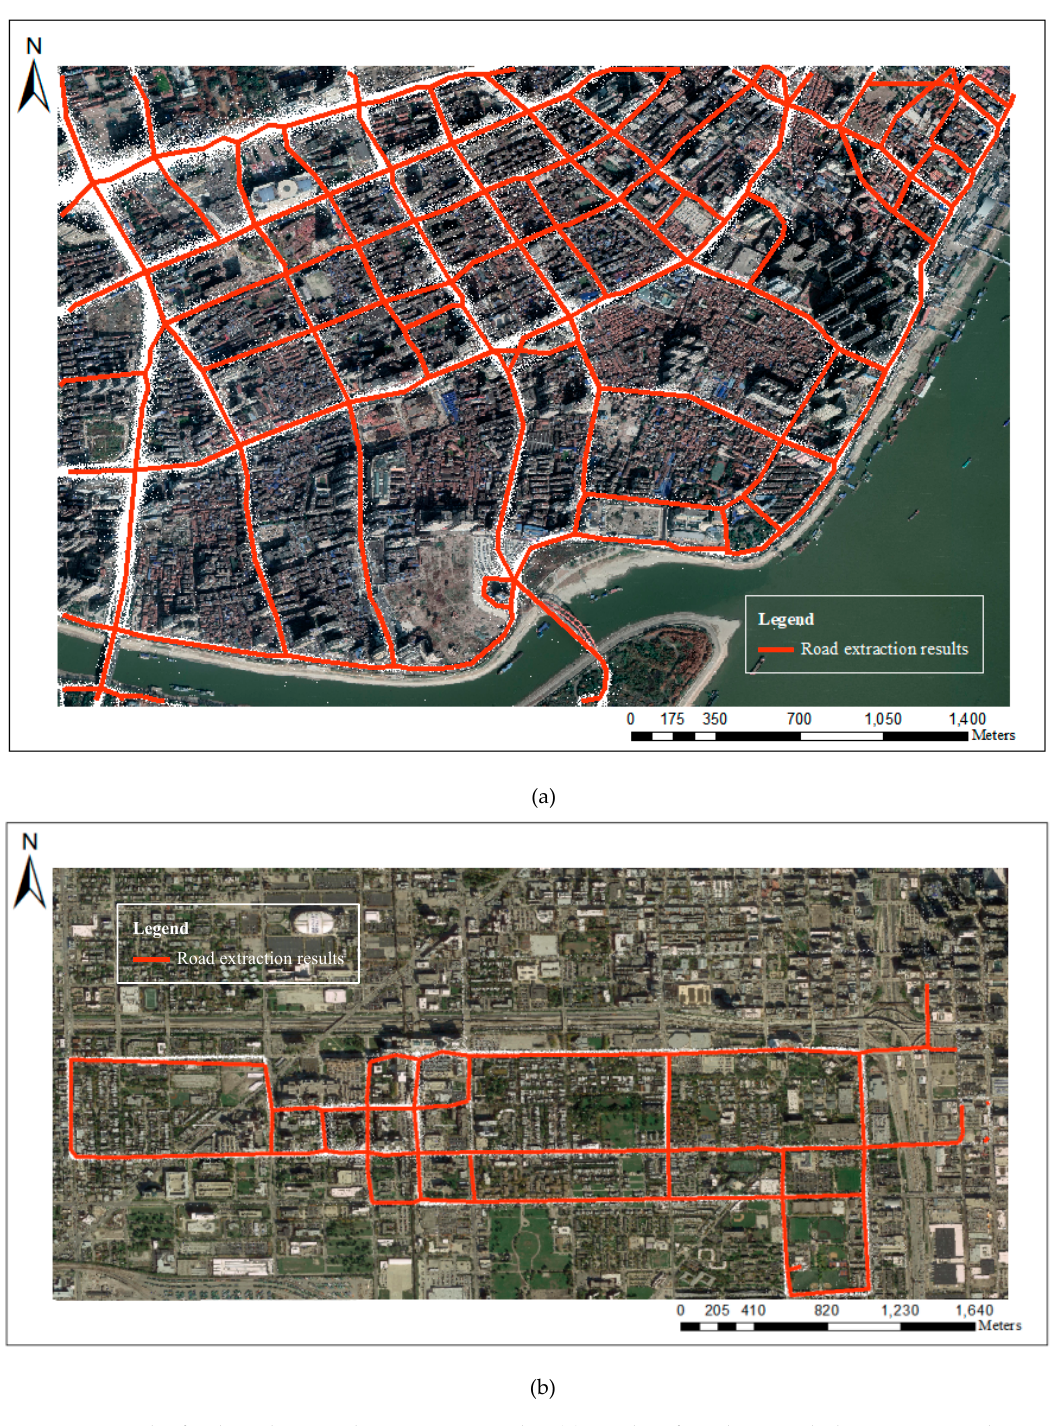
Figure 18. Intersection 69. Table 3. The single/double direction decision. Paths